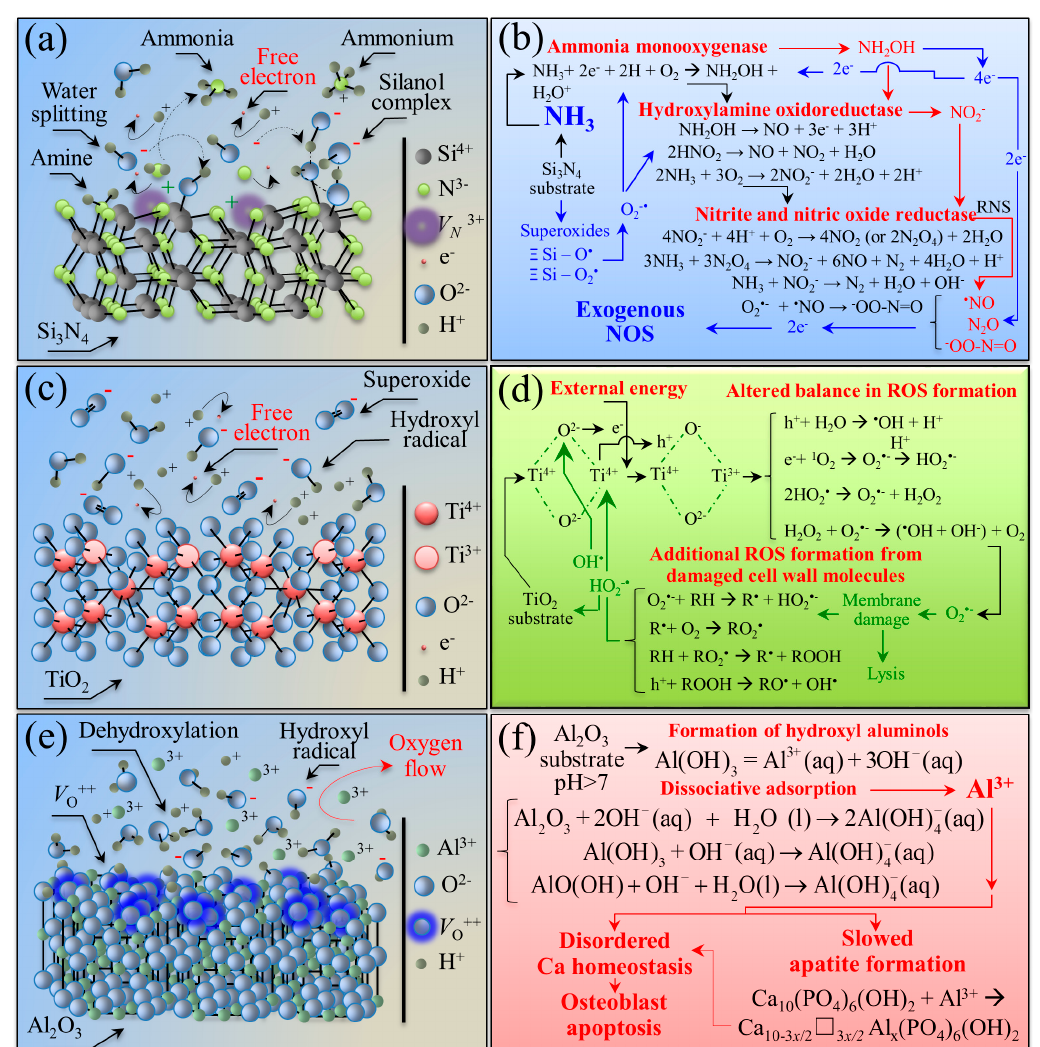
Figure 6. Schematic drafts of the free surface of different substrates in aqueous environment (Si 3 N 4 , Ti6Al4V alloy, and Al 2 O 3 in ( a , c , e ), respectively) and the cascade of related off-stoichiometric reactions (Si 3 N 4 , Ti6Al4V alloy, and Al 2 O 3 in ( b , d , f ), respectively).